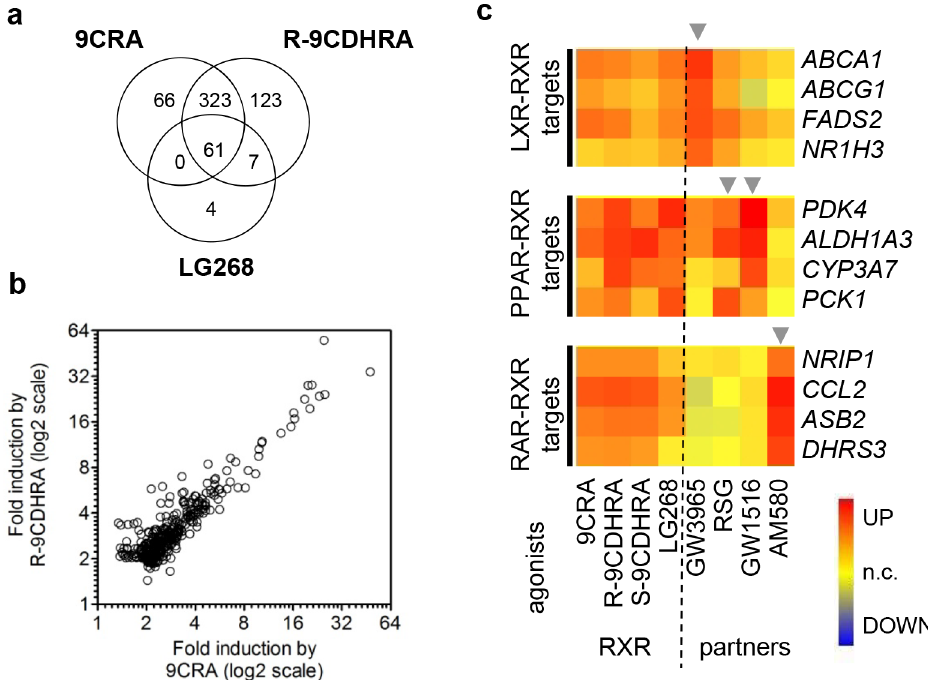
Fig 4. Molecular evidence for 9CDHRA selective activation of RXRs. (a) Significant overlap between global transcriptional changes induced by R-9CDHRA (10 -5 M), 9CRA (10 -6 M) or a synthetic RXR agonist (LG268; 10 -7 M) revealed by DNA microarray analyses in differentiating monocyte-derived human dendritic cells. (b) Scatter plot comparison of fold-changes for transcripts altered by 9CRA and R-9CDHRA treatments. (c) S- and R-9CDHRA, similarly to 9CRA and/or LG268 (see “ RXR ” columns), induced the expression of genes (see rows) identified previously as direct transcriptional targets of LXR-RXR, PPAR-RXR and RAR-RXR. Corresponding transcripts were also induced by agonists of respective RXR-heterodimer partners (see “ partners ” column and arrowheads): GW3965 (LXR α / β ; 10 -6 M), RSG (PPAR γ ; 10 -6 M), GW1516 (PPAR δ ; 10 -6 M) and AM580 (RAR; 10 -7